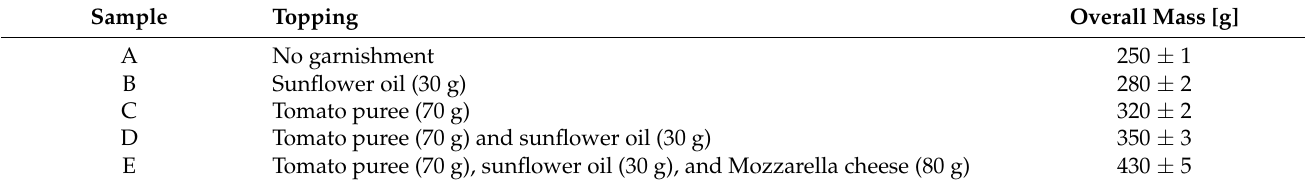
Table 1. Samples of Neapolitan pizza submitted to baking tests in the wood-fired oven used here.